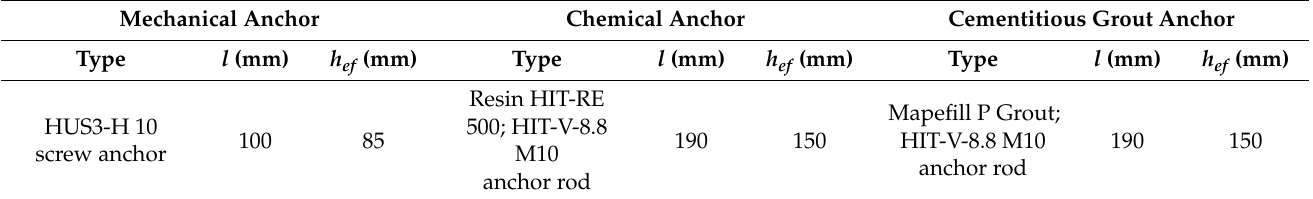
Table 4. Specifications of the anchoring systems applied on the masonry walls.